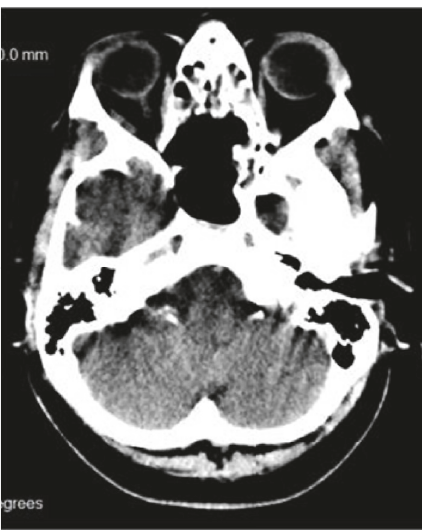
Figure 5: Postoperative CT scan showing the sphenoidotomy, the posterior ethmoidectomy, and the absence of